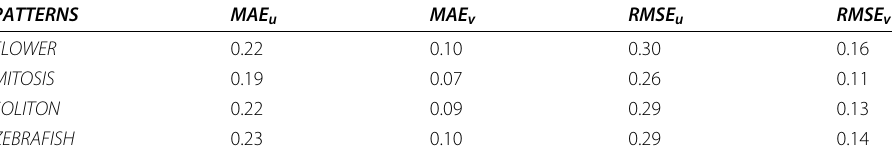
Table 3 The MAE and RMSE for the four experiments. Errors, in terms of RMSE and MAE, of the PINN provided solution with respect to numerical solution of bidimensional Gray-Scott